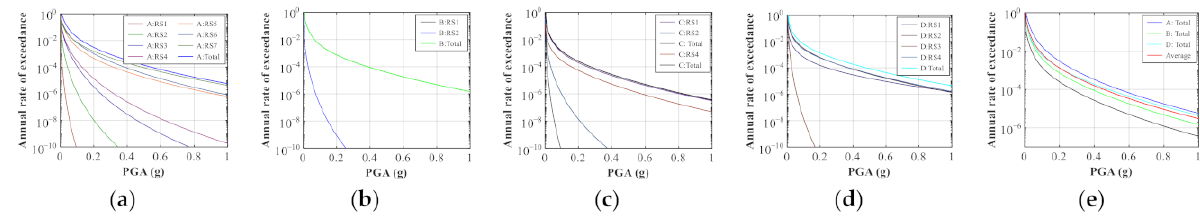
Figure 18. Seismic hazard curve on the site Bohyeonsan concrete gravity dam for seismic source model in South Korea; ( a ) Model A, ( b ) Model B, ( c ) Model C, ( d ) Model D, ( e ) Total and average hazard curve of all